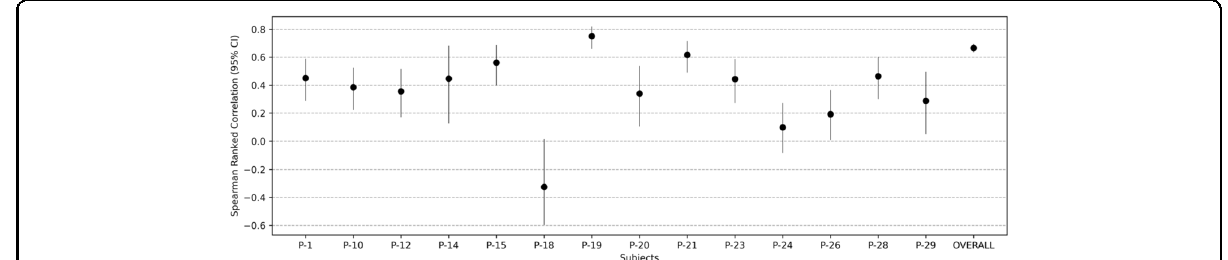
Fig. 3 Spearman rank correlation coef fi cients with 95% con fi dence interval bounds are plotted for the relationship between the predicted and observed depressed state values over time in each individual. The overall correlation obtained by concatenating the actual vs. predicted values across all subjects, is also shown as the last data point. All correlations were signi fi cant except in P-18 and P-24. Actual correlation values are shown in Supplementary Table